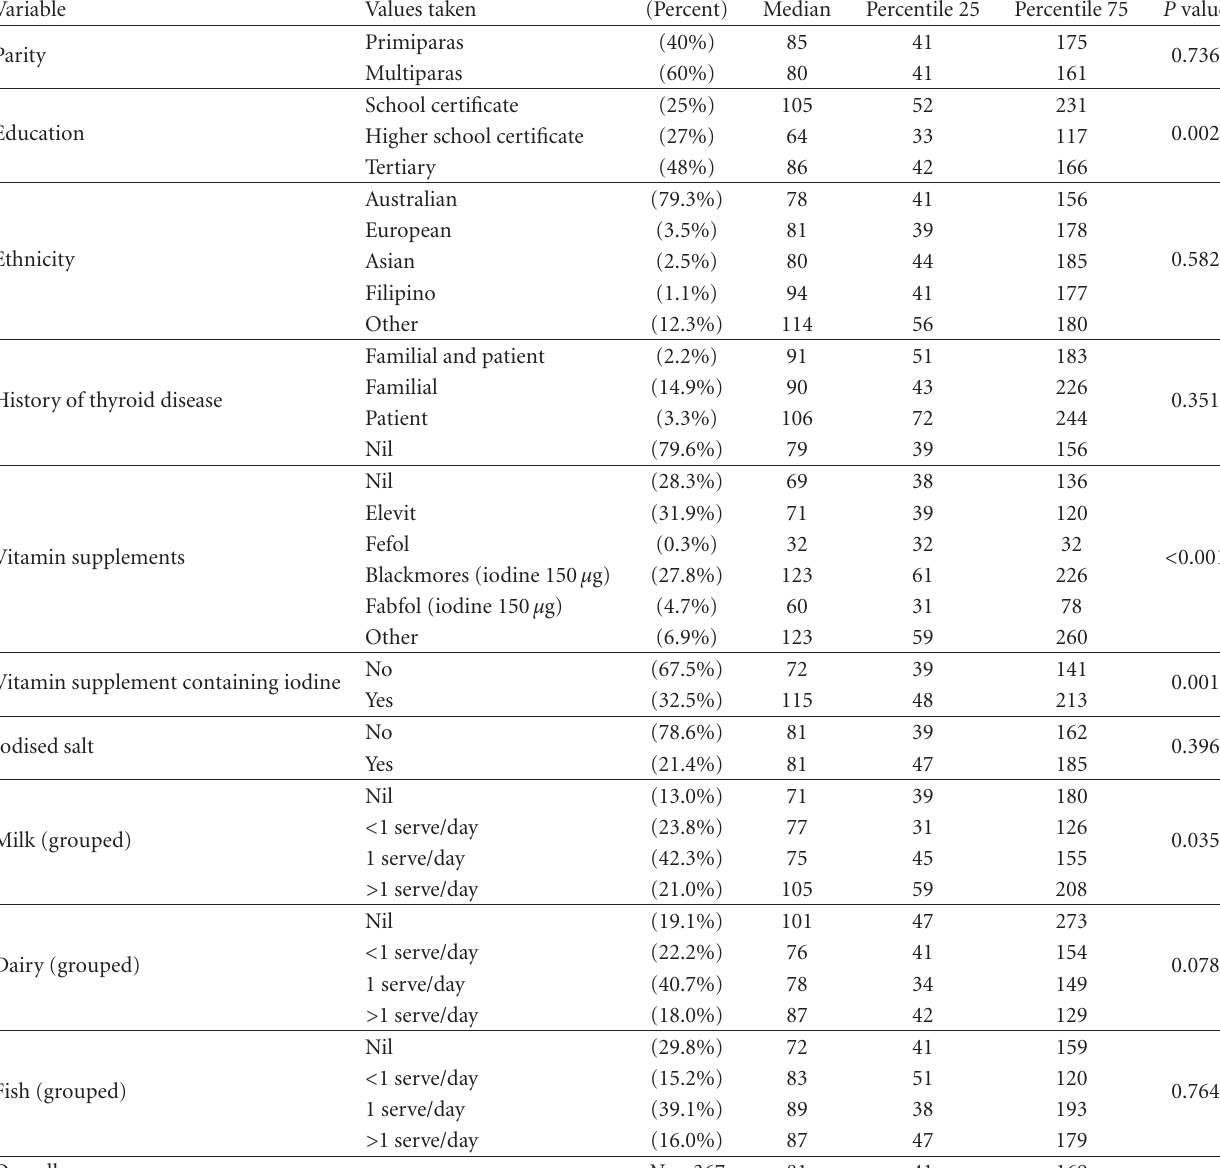
Table 2: Median and quartiles for UIC by subgroup and P value for test of homogeneity across